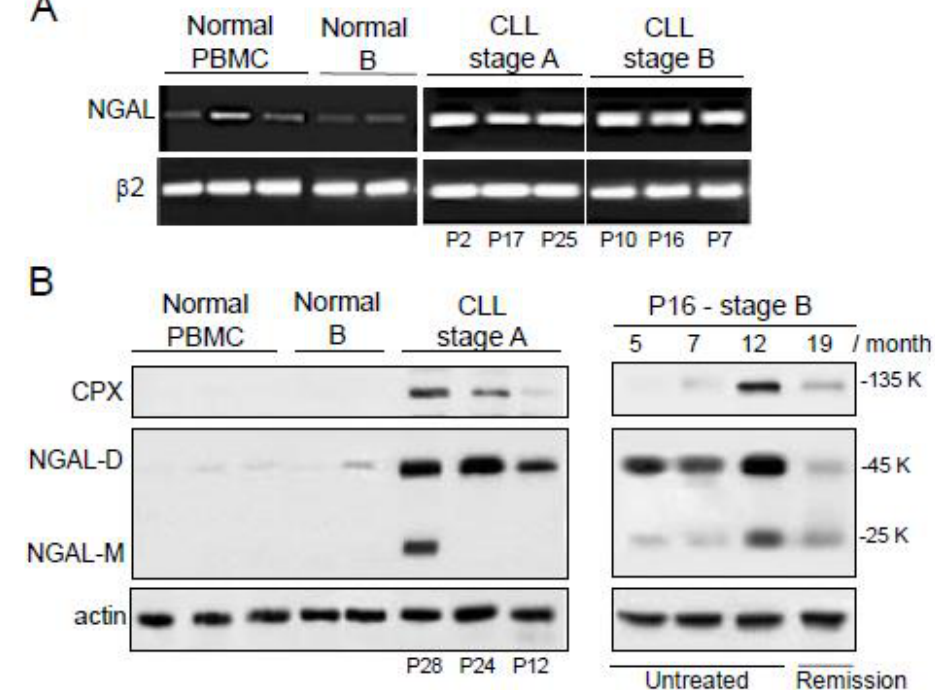
Figure 2. Expression profiles of NGAL in peripheral blood mononuclear cells (PBMCs) from healthy individuals, untreatedCLLpatientsandpatientP16beforeFCRtreatmentoratremission. ( A ) Representative RT-PCR results for three PBMCs and two purified CD19 + B cells from healthy donors, and six CLL cells from untreated patients. ( B ) Representative Western blot (non-reducing conditions) results (left panel) for three PBMCs and two purified CD19 + B cells from healthy donors, and three CLL cell samples from untreated CLL patients (stage A). Western blot (non-reducing conditions) results (right panel) for CLL cells of patient P16 (stage B) before FCR treatment (months 5, 7, and 12) or at remission (month 19). The primary antibodies used were anti-NGAL specific for the dimeric and monomeric forms (R&D Systems) and anti-MMP-9 which recognizes CPX